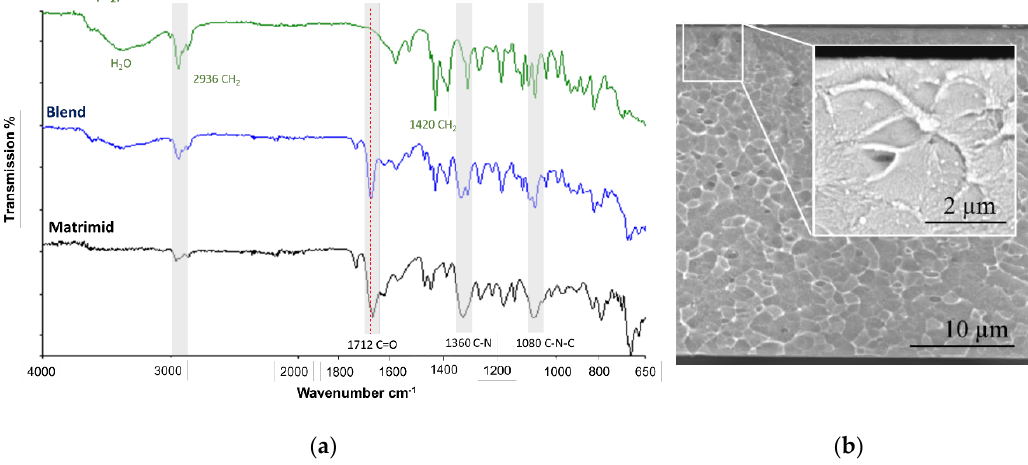
Figure 2. ( a ) ATR-FTIR spectra of the Matrimid ® 5218/PIM-EA(H 2 )-TB blend and neat polymer membranes, and ( b ) SEM cross-sectional image of the Matrimid ® 5218/PIM-EA(H 2 )-TB blend membrane at a magnification of 8000× and 30,000× at an accelerating voltage of 10 kV.